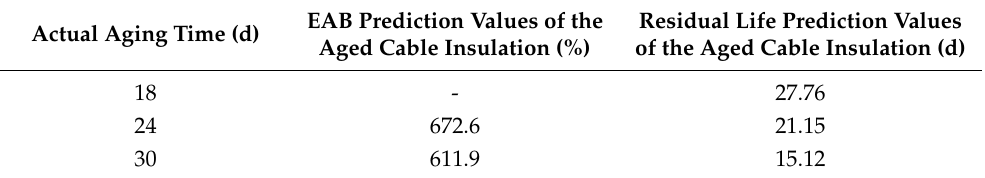
Table 2. Prediction values of the EAB and the residual life of the thermal-aged cable insulation at 154 ◦ C. Actual Aging Time